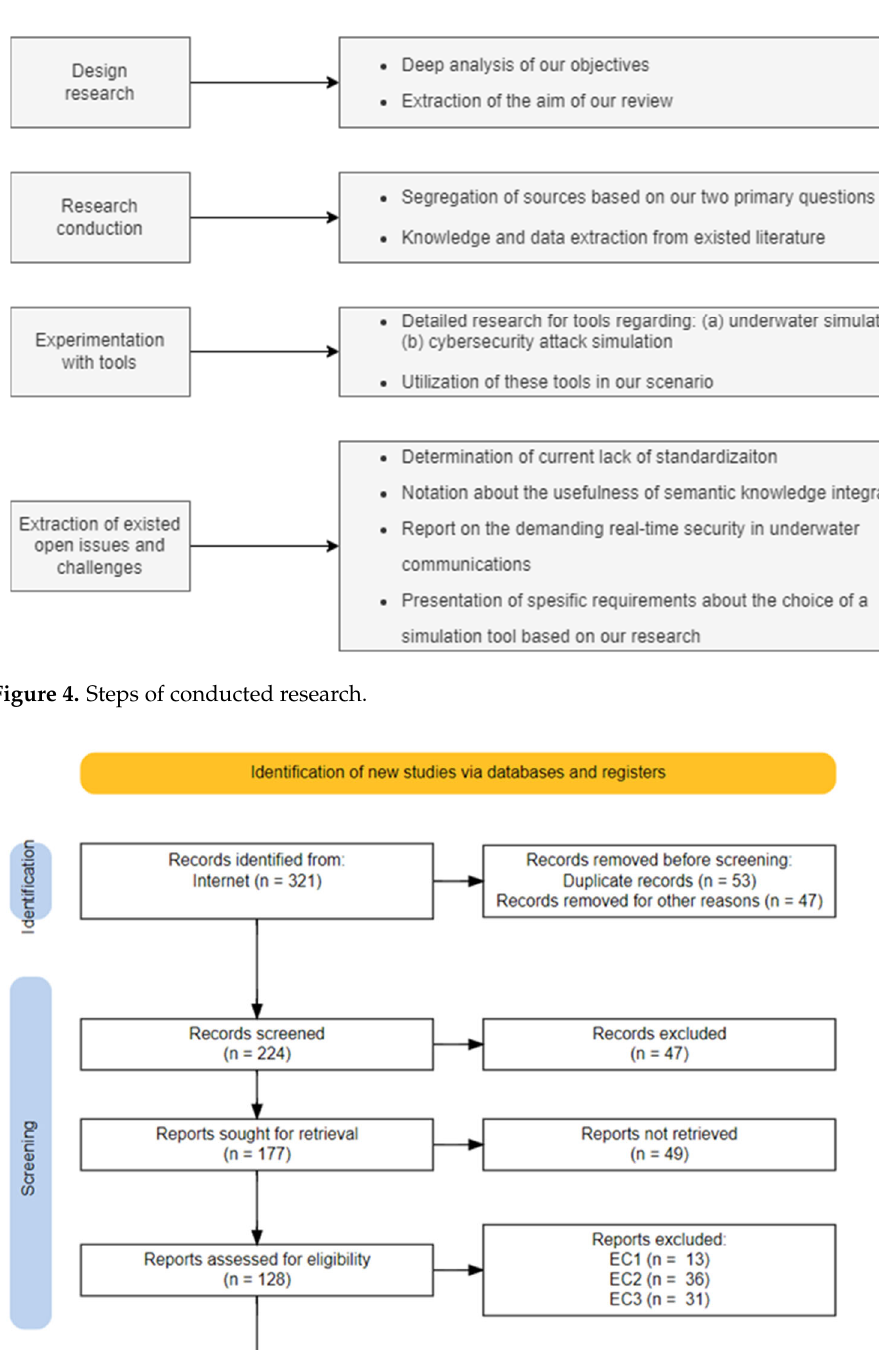
Figure 6. PRISMA flowchart of second primary question.